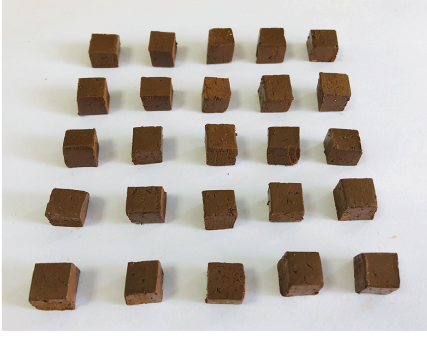
Figure 2: Artificial clay